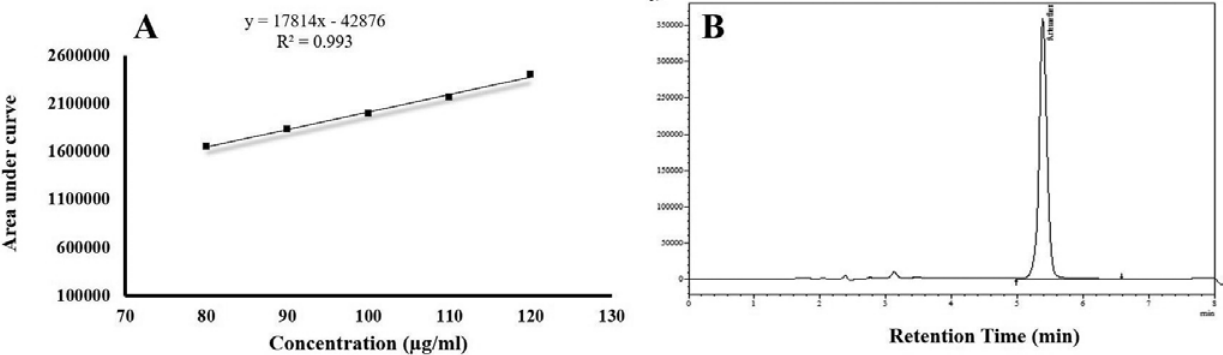
FIGURE 1 - (A) calibration curve of HPLC method showing linearity over a range of 80-120 µg/mL, (B) HPLC standard chromatogram showing retention peak of artemether at 5.123